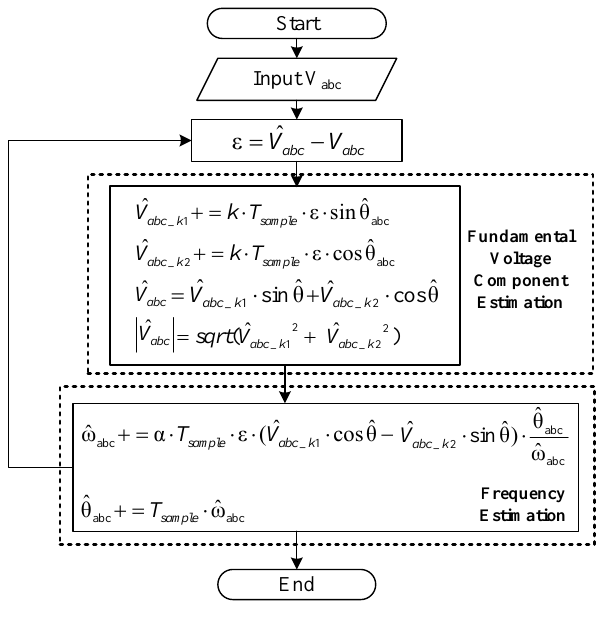
Figure 8. Flowchart of proposed algorithm.